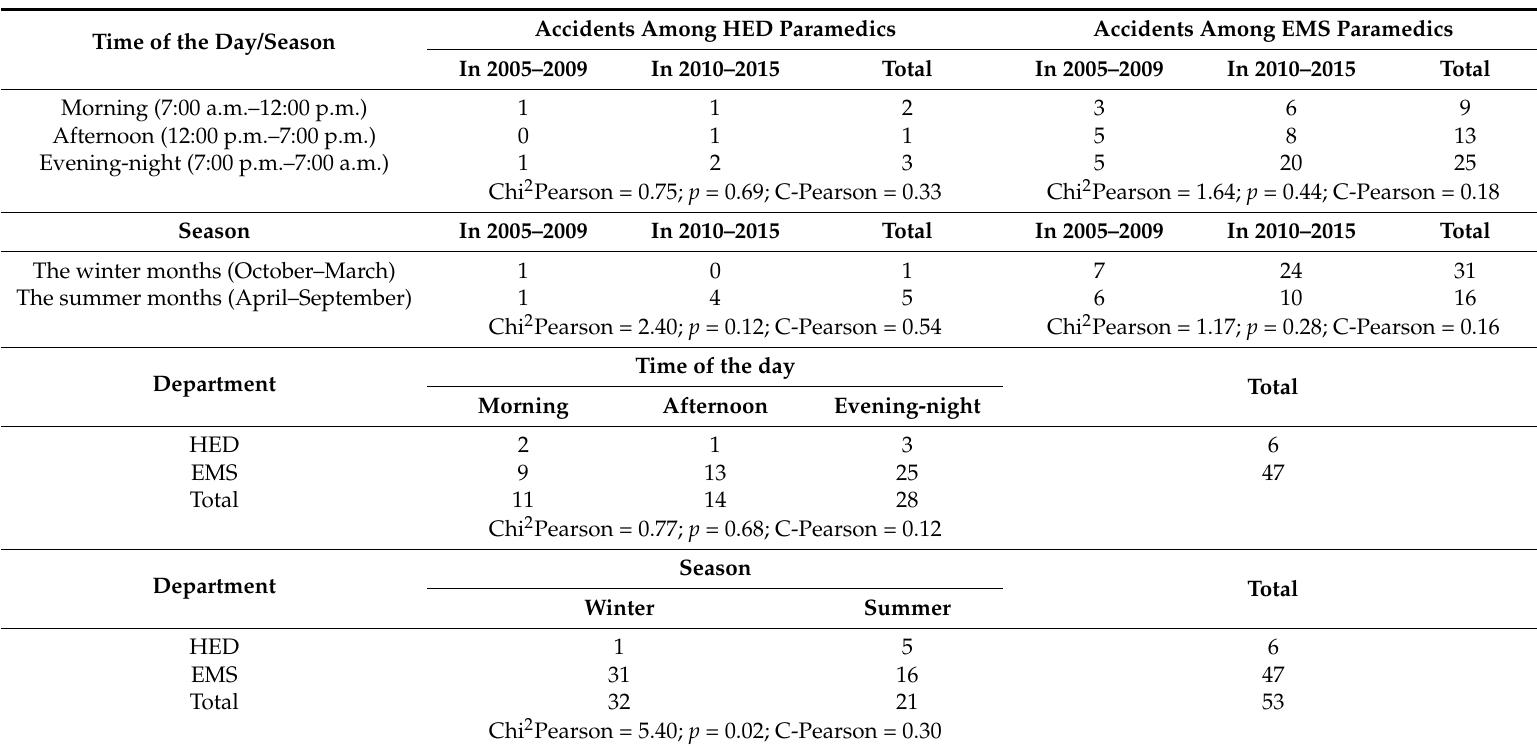
Table 3. Accidents at work among paramedics (including paramedic drivers) by the time of the day and season. Accidents Among HED Time of the Day/Season